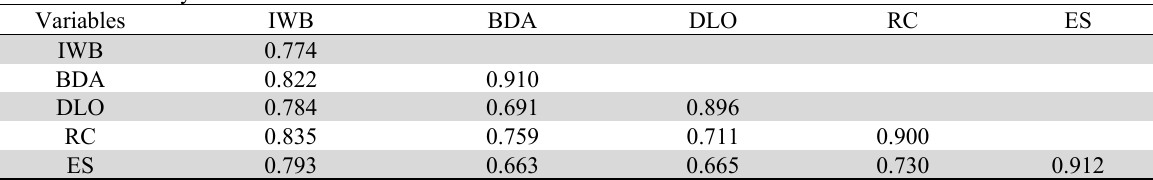
Discriminant Validity